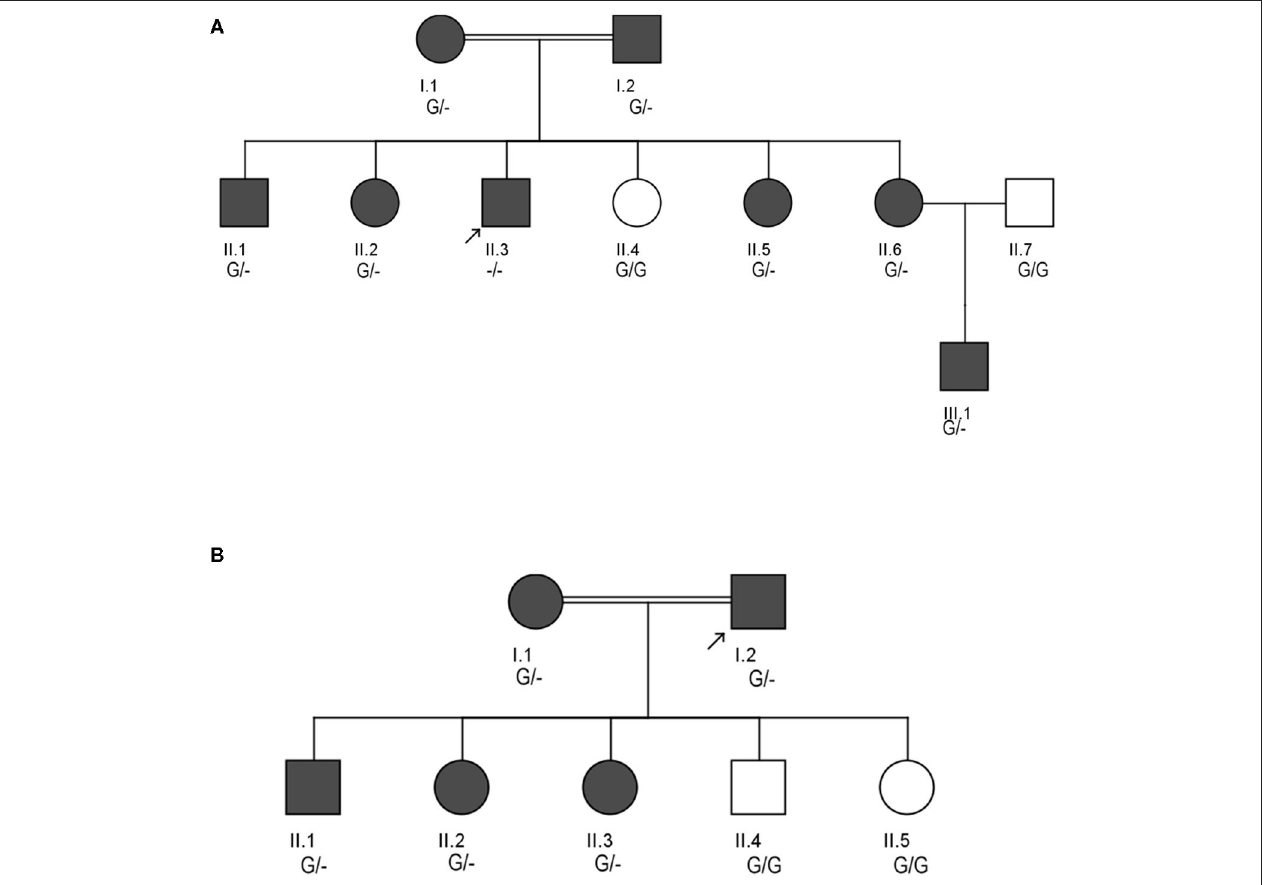
FIGURE 1 | Pedigrees showing the autosomal dominant inheritance mode for LDLR variant (c.2027delG) in two different Saudi FH Families (A,B) . Arrow indicates the index case who was first seen in our clinic. The zygosity of the variant’s genotype is mentioned under the subjects. Dark color circles or boxes in the pedigree indicates subjects with